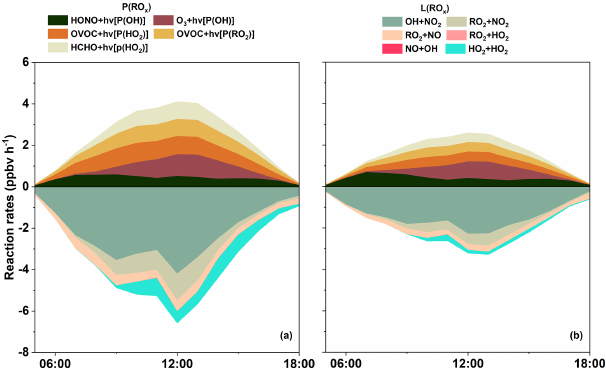
Figure 5. Simulated primary daytime sources and sink of RO x in S0 (a) and S1 (b) .